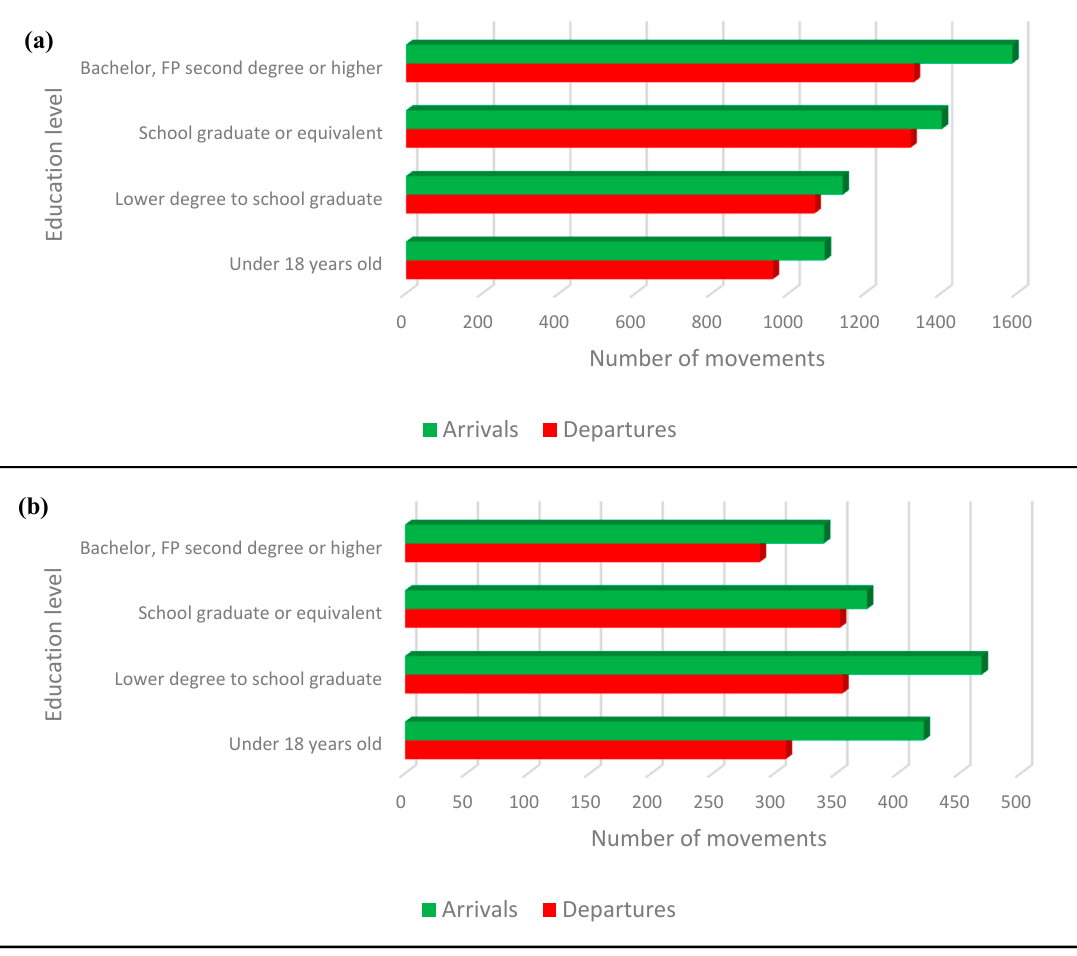
Figure 7. Migration balance in Cabanyal ( a ) and zone 0 ( b ) based on education level, 2014–2016.